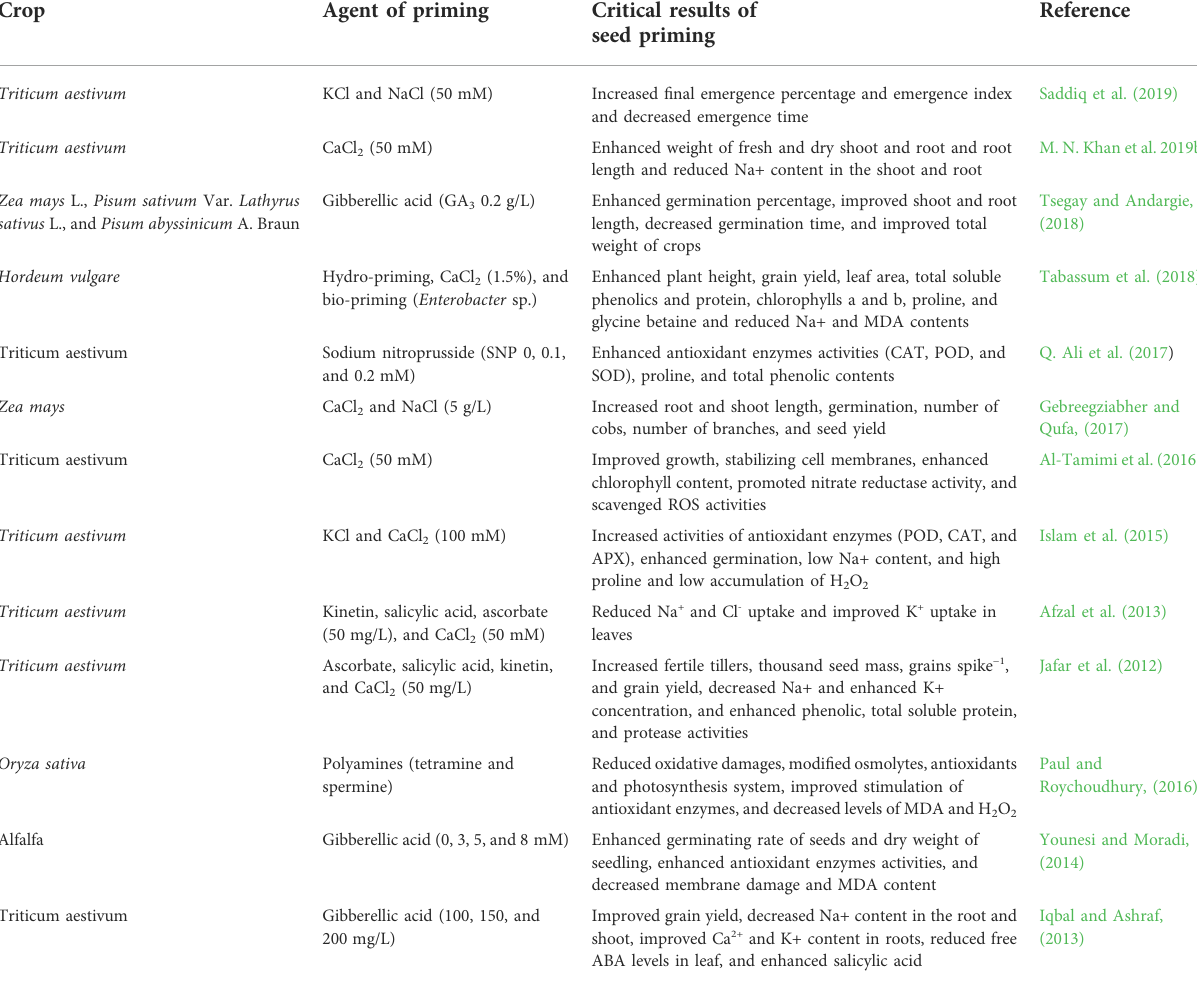
TABLE 1 Effect of various priming agents to alleviate salinity stress in different